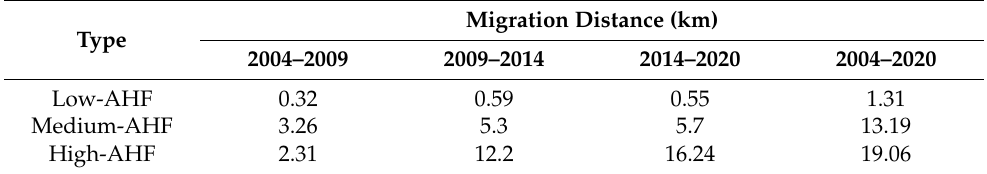
Table 8. Migration distances of different anthropogenic heat level types.